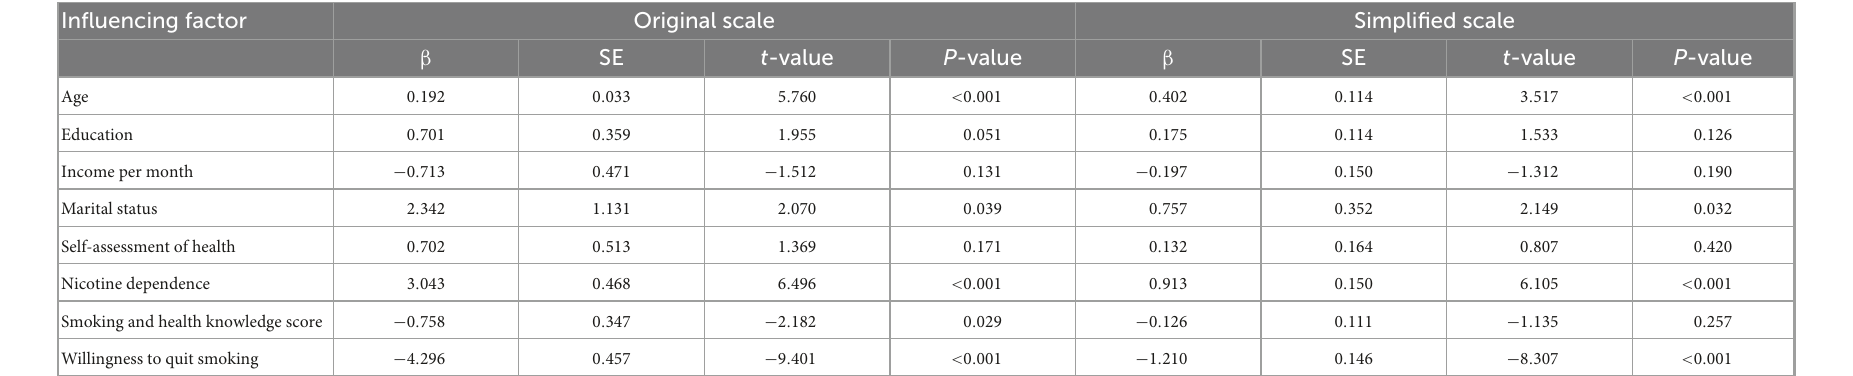
TABLE 7 Analysis of factors affecting SRB scores as measured by the original and simplified